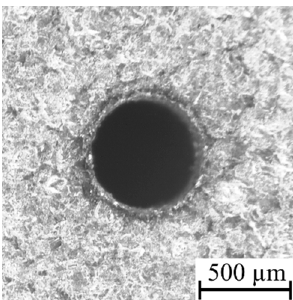
Figure 11. The entrance diameter of a micro-hole fabricated by the open voltage U = 100 V and t on = 550 µs, I = 3.33 A, p = 7 MPa, n = 300 rpm. Materials 2020 , 13 , x FOR PEER REVIEW